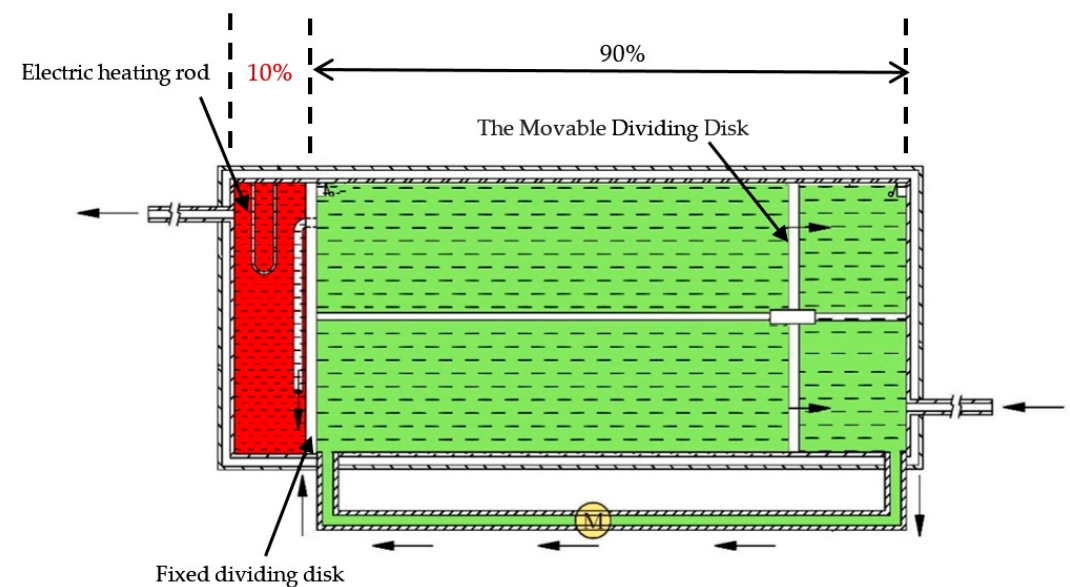
Figure 11. Proportional location of the fixed dividing disk of the 4th generation water heating tank.